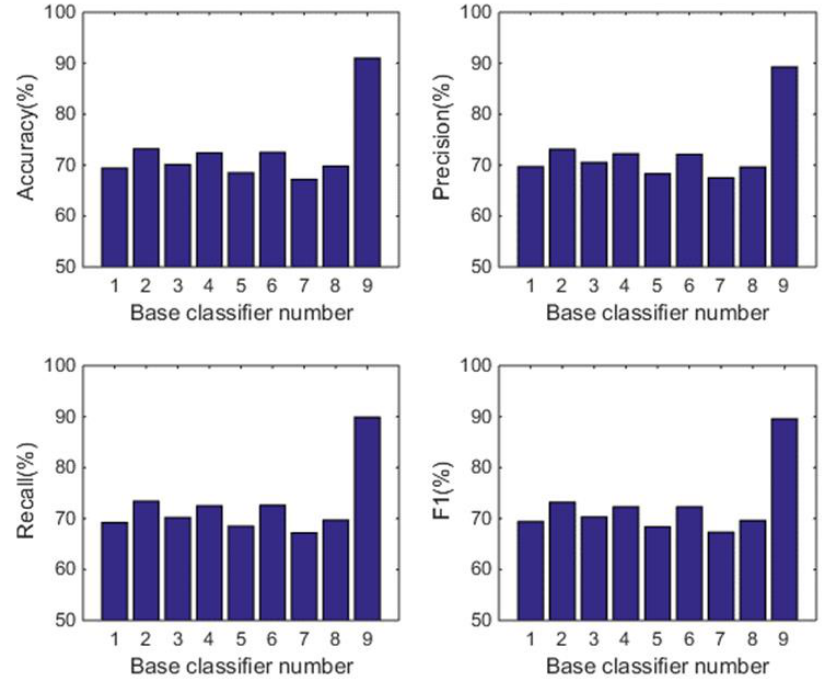
Figure 5. Performance comparison between base classifiers (1 – 8) and our fused classifier (9) for subject 2 in OPPORTUNITY dataset.